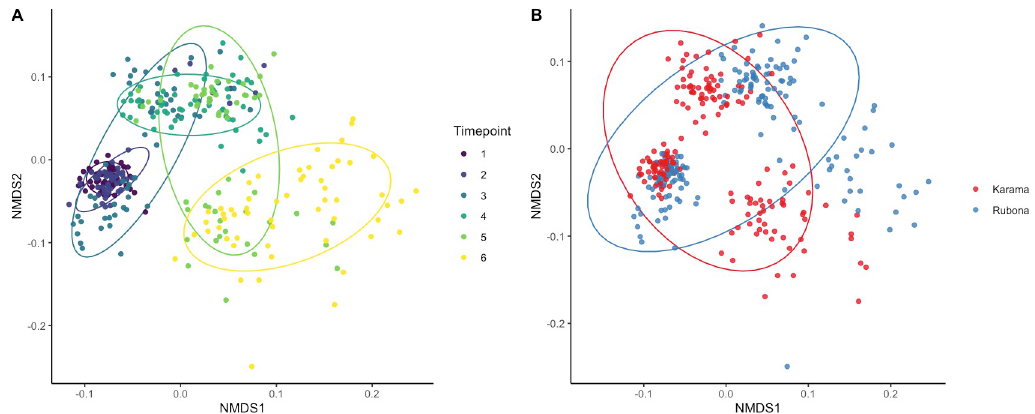
Fig 2. NMDS ordinations of gene co-occurrences at two locations in Rwanda across 6 sampling periods using a Spearman’s dissimilarity matrix. Gene co-occurrences were strongly driven by seasonal factors (A) and secondarily by location (B).